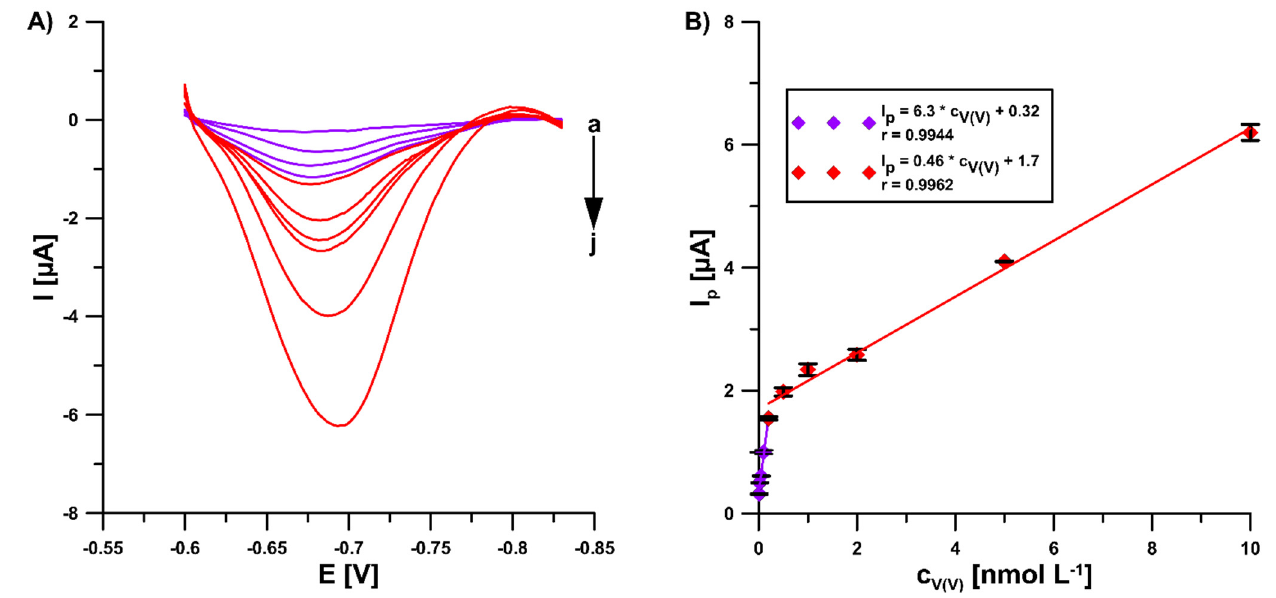
Figure 6. ( A ) The DPAdSV curves recorded in 0.3 mol L − 1 buffer solution (CH 3 COONH 4 , CH 3 COOH, and NH 4 Cl) of pH 5.6 ± 0.1, 5.0 × 10 − 4 mol L − 1 Pb(II), 7.0 × 10 − 4 mol L − 1 cupferron at the GCE/PbF in the presence of various V(V) concentrations (a → j, 1.0 × 10 − 11 –2.0 × 10 − 8 mol L − 1 ). ( B ) V(V) calibration graph. The parameters: 100 mV ( Δ E A ), 20 mV s − 1 ( ν ), and 2 ms (t m ). The average values of Ip are presented with the standard deviation of n = 3. Table 2. Comparison of voltammetric procedures for V(V) analysis.